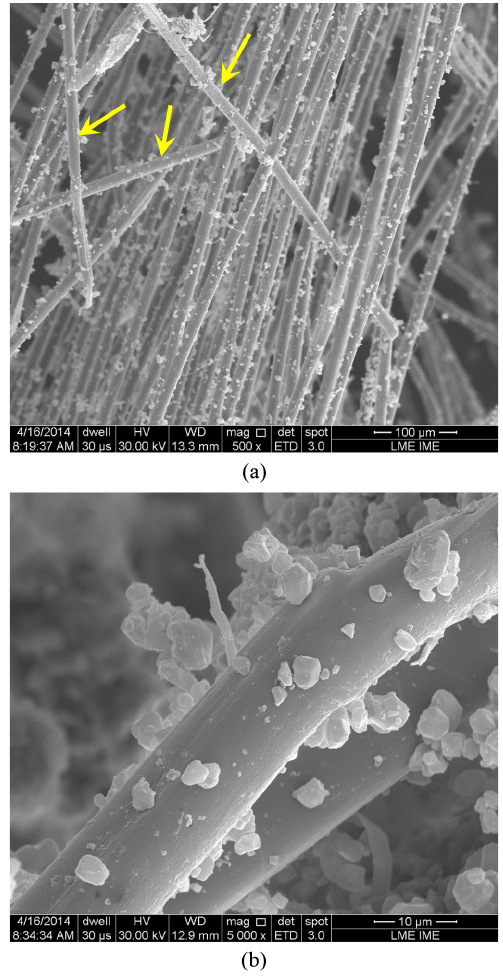
Figure 5. Damaged aramid fabric by fragments (projectile/ceramic) after the ballistic impact: (a) lower magnification, showing aramid fibers pulled out (arrows) from the yarn, and (b) higher magnification.